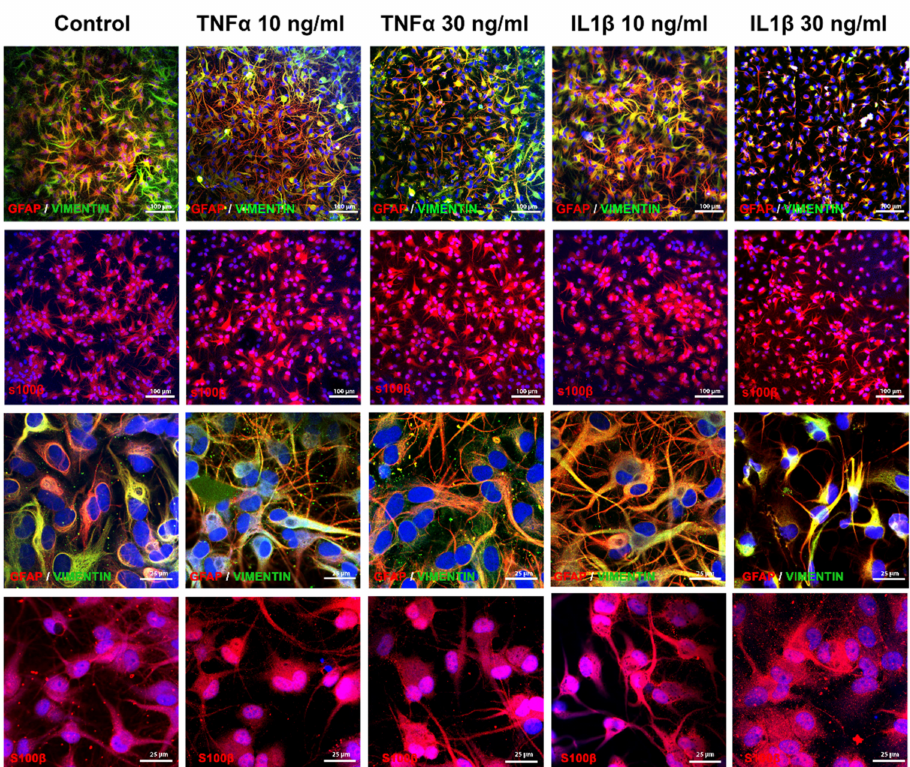
Figure 3. Exposure to cytokines induces morphological modifications in human ReN-derived astro- cytes. Double immunostaining for GFAP and vimentin and immunostaining for S100B in control and after 24 h of exposure to TNF α or IL1 β . First and second rows: low magnification; third and fourth rows: high